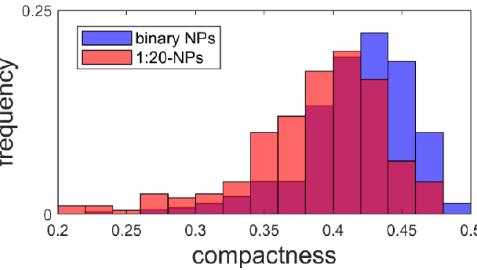
12 of 22 Figure 6. The 1:20-NPs deposited on HOPG. ( A ) Topography. ( B ) Line profiles of a proticle. ( C ) Equivalent diameter distribution. ( D ) Height distribution. ( E ) Volume distribution ( N = 200). The shape of the measured structures can be described by the compactness 𝐶 , given in Equation (2):